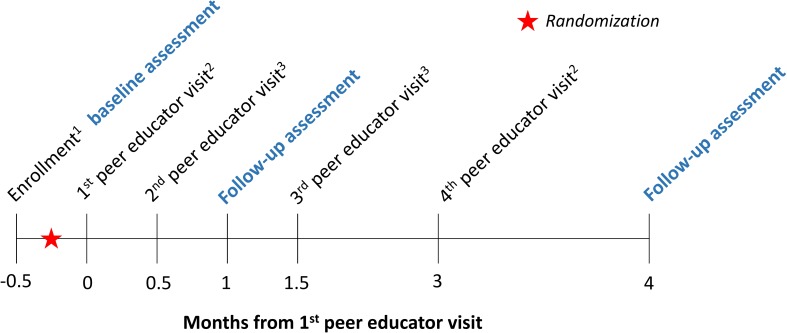
Time line of study interventions and assessments (conducted by research assistants, in blue).Participants were randomized in groups of 1 peer educator and 8 FSWs. The text following the subscripts below describe details about each peer educator visit: 1Research assistants gave all participants a referral card for free HIV testing and a study contact card. The referral card could be used at 10 private healthcare facilities participating in this study. The study contact card included a toll-free hotline number, which participants could call for information about linkage to care, to report potential adverse events, or to ask questions related to HIV self-testing (intervention arms only). 2The peer educators gave all participants condoms. In the direct provision arm, the peer educators additionally gave the participants oral HIV self-tests; in the facility collection arm, participants received coupons, which they could exchange for an HIV self-test at the participating healthcare facilities. 3The peer educators gave all participants condoms.